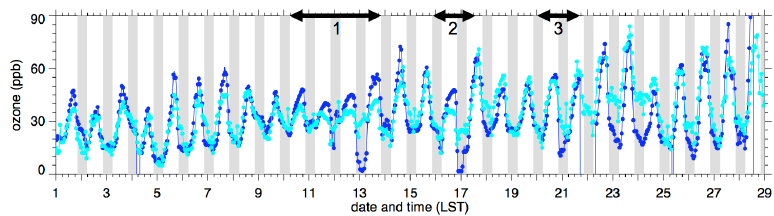
Figure 7. Observed ozone at the T0 site (dark blue) and from the CARB observations at Cool (light blue). Gray shading denotes nighttime periods and arrows denote three periods of northwesterly synoptic flow. 986 Table 3. Statistics quantifying the performance of predicted meteorological variables and carbon monoxide along the 21 G-1 aircraft flights during CARES, where IA is the Index of Agreement that varies between 0 (no agreement) and 1 (perfect agreement).